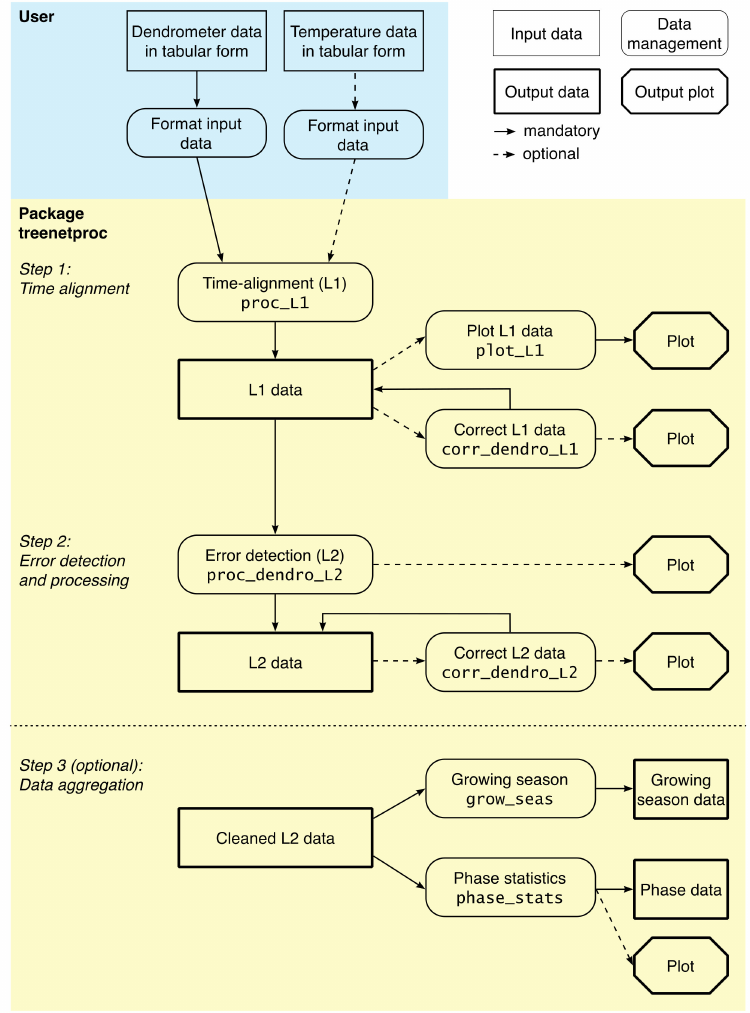
Figure 2. Workflow of treenetproc. Functions of the package are shown in rounded rectangles, including a description of the functionality (first line) and the name of the function (second line). Outputs of the functions are shown as rectangles (data output) and octagons (graphical output). Solid arrows indicate the regular workflow, dashed arrows indicate the optional, user-induced